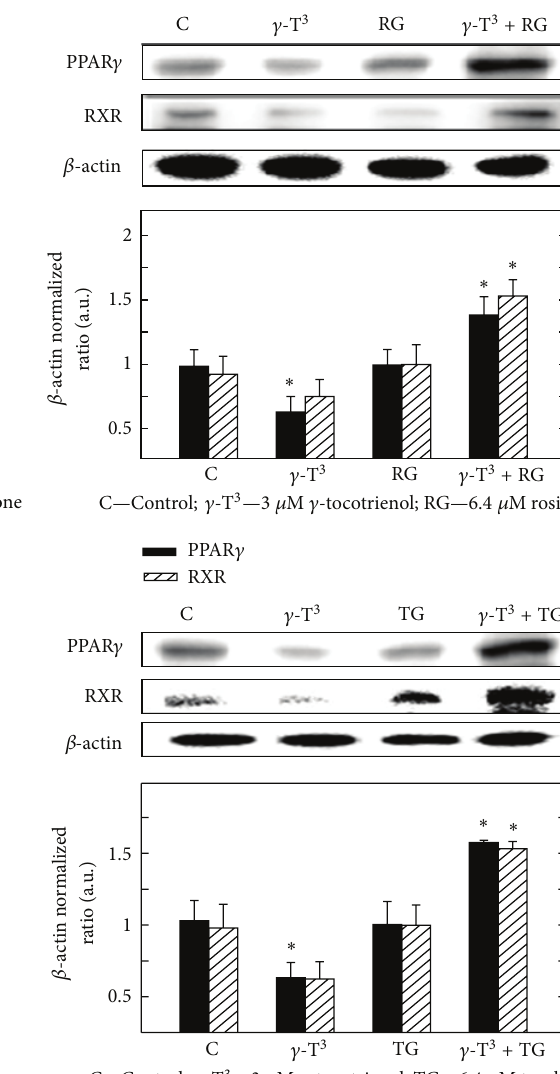
∗∗ troglitazoneC—Control;C—Control; F 5: Western blot analysis of -tocotrienol and PPAR agonists (rosiglitazone and troglitazone) given alone or in combination on the levels of PPAR and RXR aer a 4-day incubation period in (a) MCF-7 and (b) MDA-MB-231 human breast cancer cells. MCF-7 cells were cells/100mm culture dish and treated with control or treatment media containing 2 initially plated at 𝛾𝛾 𝛾𝛾 rosiglitazone, or troglitazone alone or in combination. MDA-MB-231 cells were plated in a similar manner and treated with control or 𝛾𝛾 6 treatment media containing either 3 M -tocotrienol, 6.4 M rosiglitazone, or 6.4 M troglitazone alone or in combination. All cells were 1 × 10 fed fresh treatment media every other day for 4-day incubation period. Aerwards, whole cell lysates were prepared for subsequent separation by polyacrylamide gel electrophoresis (50 g/lane) followed by Western blot analysis. Scanning densitometric analysis was performed on all 𝜇𝜇 𝛾𝛾 𝜇𝜇 𝜇𝜇 blots done in triplicate and the integrated optical density of each band was normalized with corresponding -actin, as shown in bar graphs below their respective Western blot images. Vertical bars in the graph indicate the normalized integrated optical density of bands visualized 𝜇𝜇 in each lane SEM. as compared with vehicle-treated 𝛽𝛽 ±